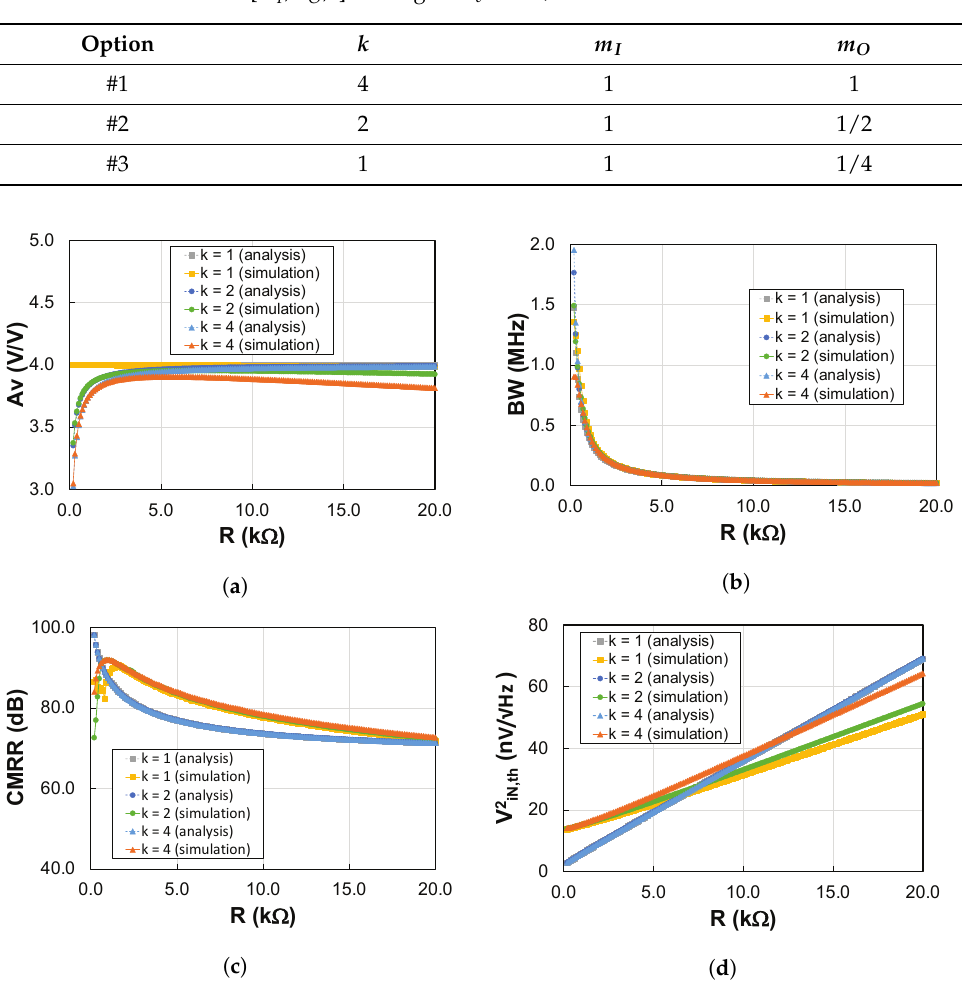
Figure 5. Analytical and simulated response of the ICF IA in terms of ( a ) A v ( b ) BW, ( c ) CMRR, and ( d ) thermal noise vs. R